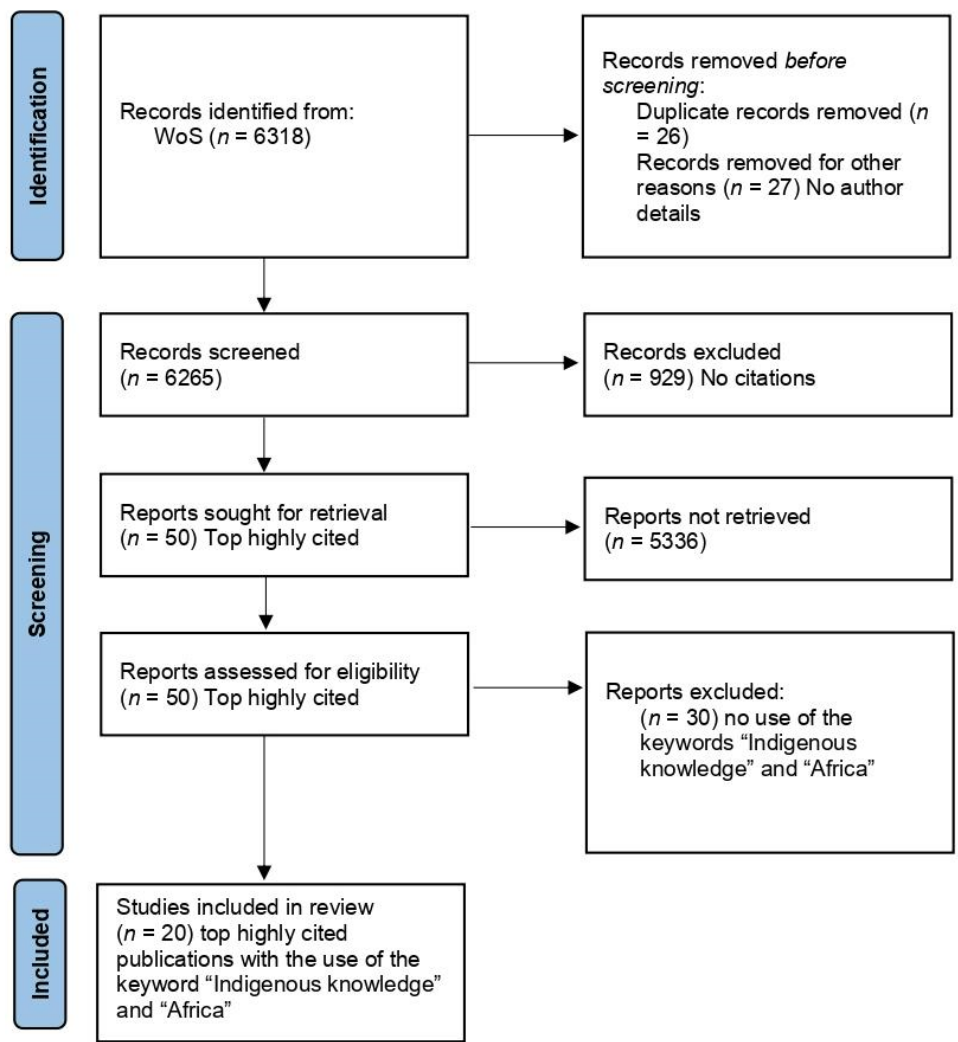
Figure 2. Systematic review process flow diagram of the selection process of publications for WoS, based on PRISMA.